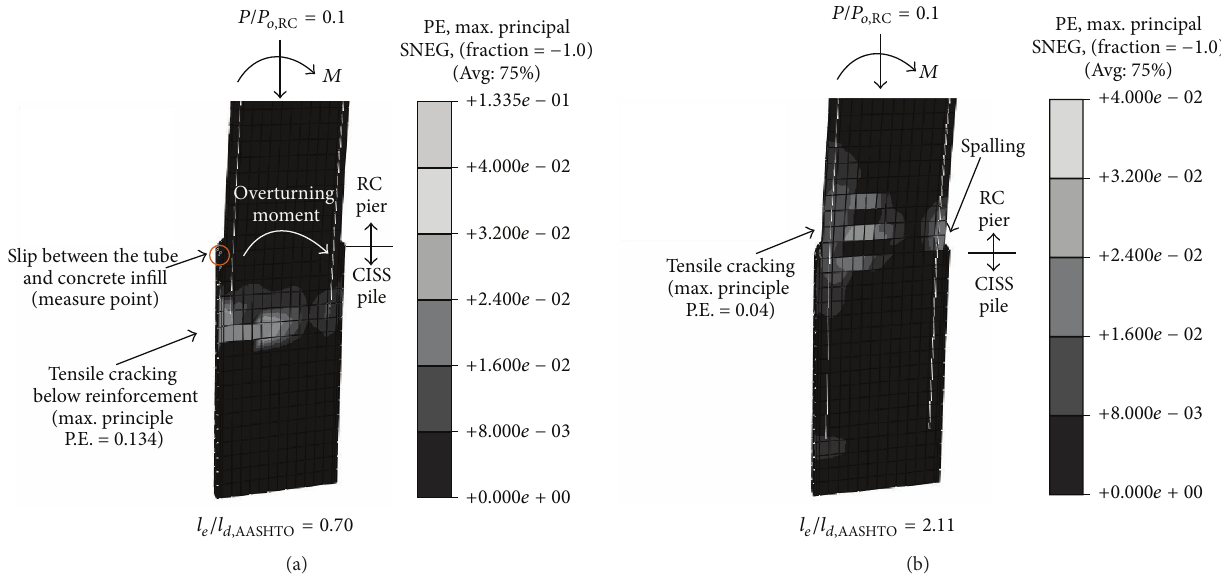
Figure 8: Crack pattern and failure mechanism for different embedment lengths: (a) 𝑙 𝑒 = 0.70𝑙 𝑑, AASHTO and (b) 𝑙 𝑒 = 2.11𝑙 𝑑, AASHTO .